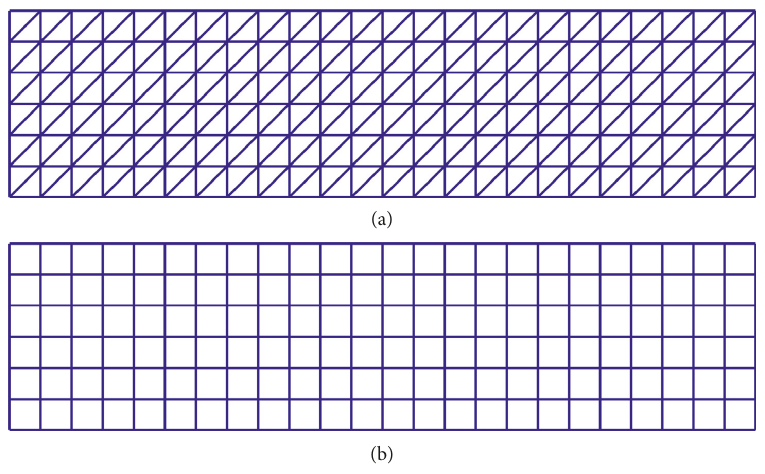
Figure 4: Beam domain discretization using triangular and quadrilateral elements.